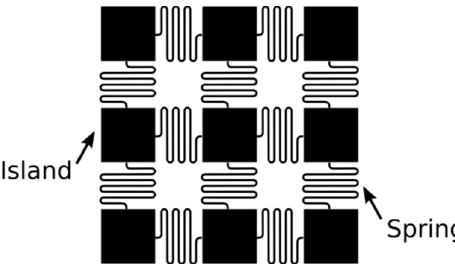
Figure 1. General concept of the stretchable silicon design. Rigid silicon islands are interconnected by silicon serpentine springs.